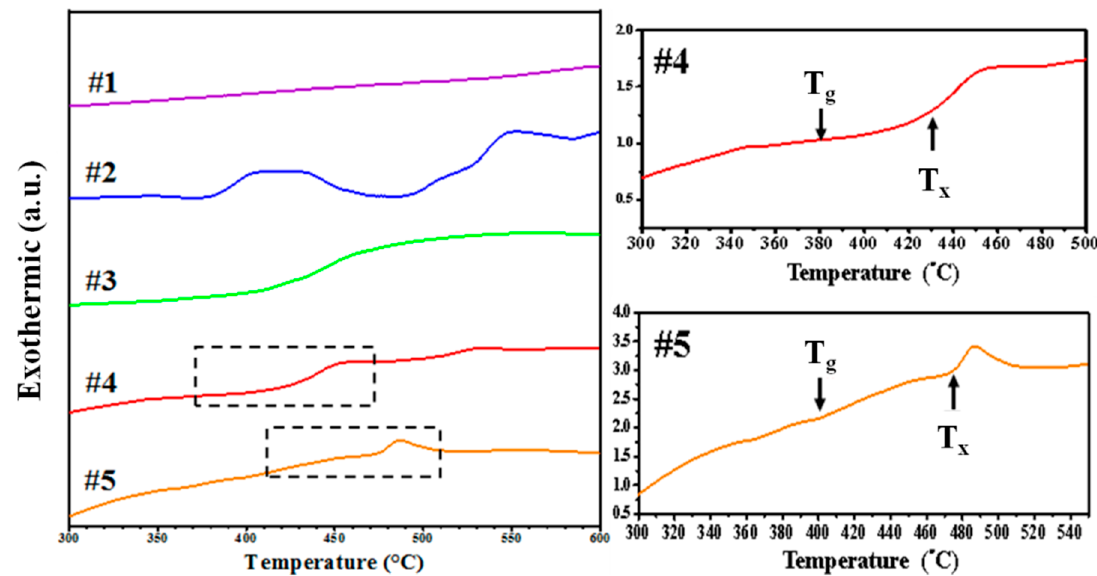
Figure 6. DSC thermograms from Zr-Cu-Ti films of various compositions (#1–#5).